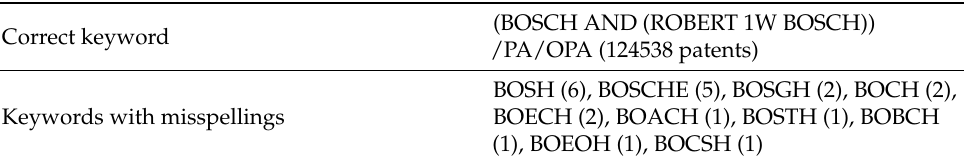
Table 8. Keywords (correct and with misspellings) used to search patents with the applicant BOSCH and number of patents retrieved for each of